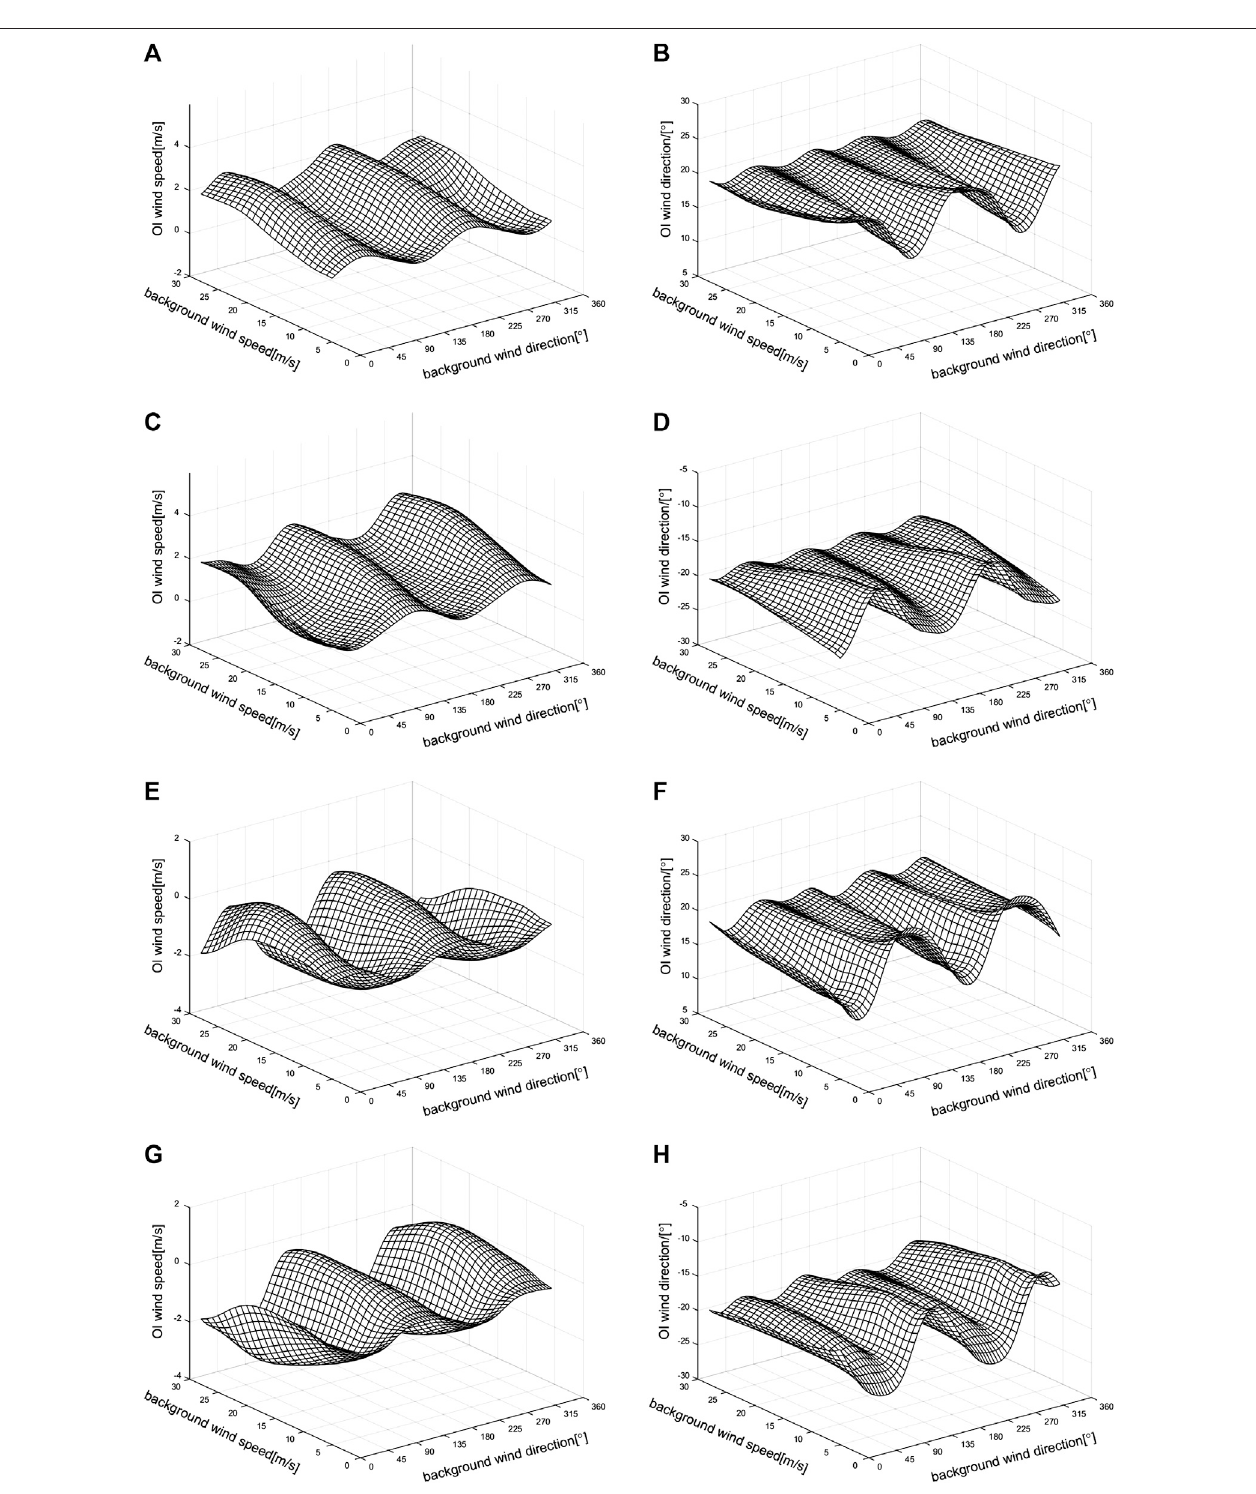
FIGURE 5 | OI-retrieved wind errors under different background wind error conditions: for (A) and (B) the background wind speed and direction errors are 2 m/s and 20 ° ,respectively;for (C) and (D) ,thebackgroundwindspeedanddirectionerrorsare2 m/sand − 20 ° ,respectively;for (E) and (F) ,thebackgroundwind speedand direction errors are − 2 m/s and 20 ° , respectively; for ( G) and (H) , the background wind speed and direction errors are − 2 m/s and − 20 ° , respectively.